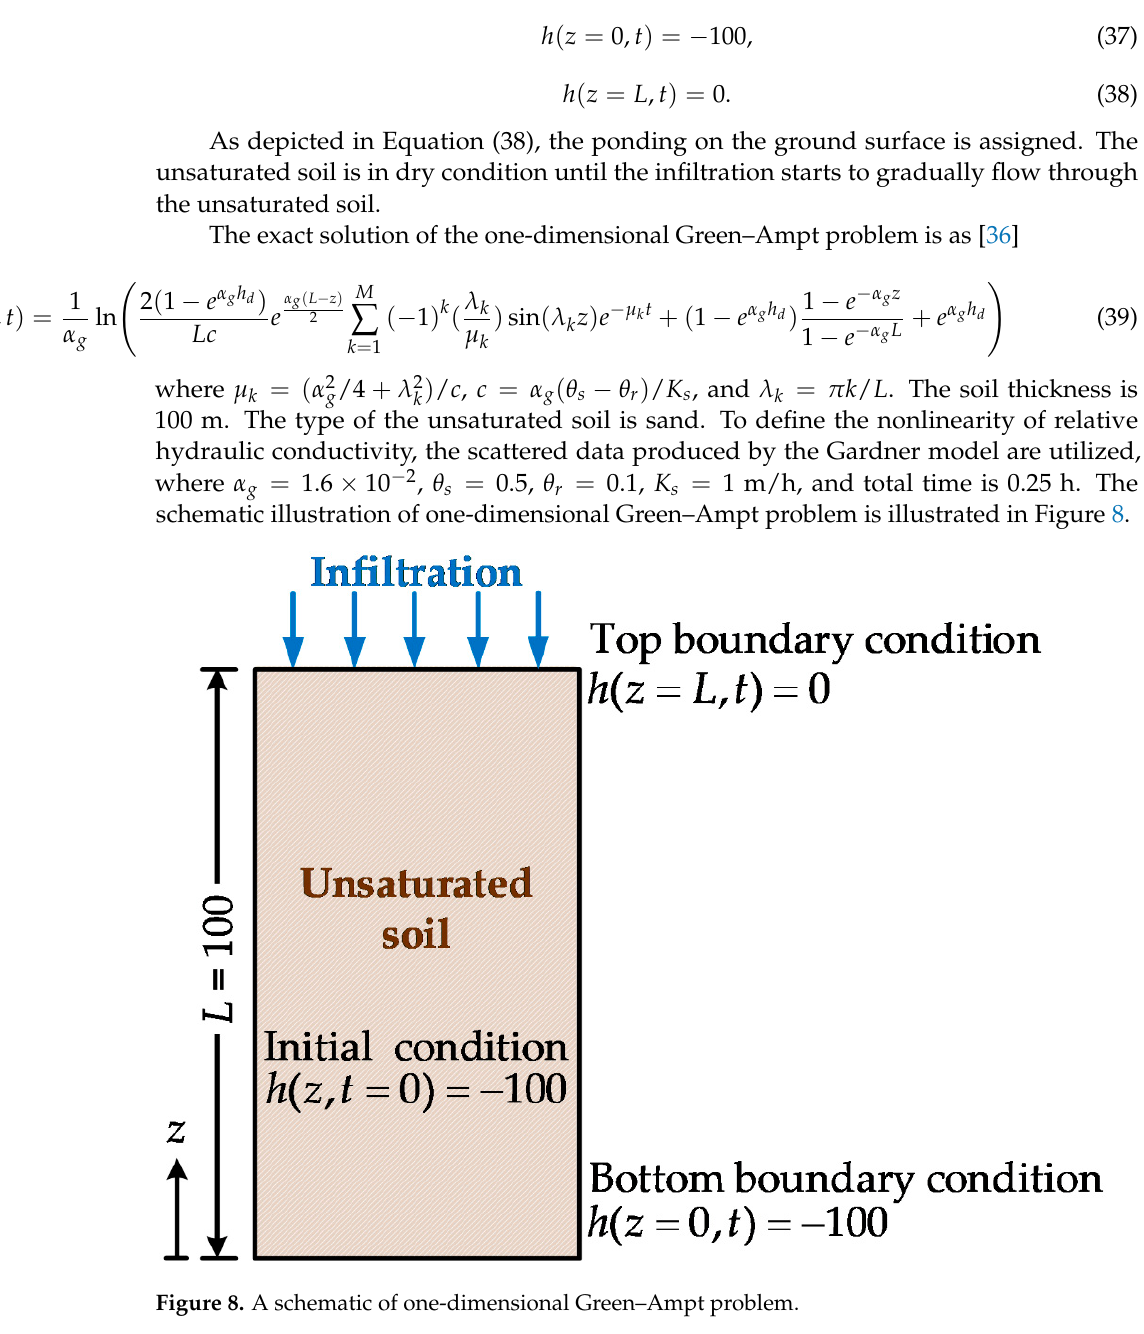
Figure 9. Comparing effective saturation using RBF with scattered data by the Gardner model.